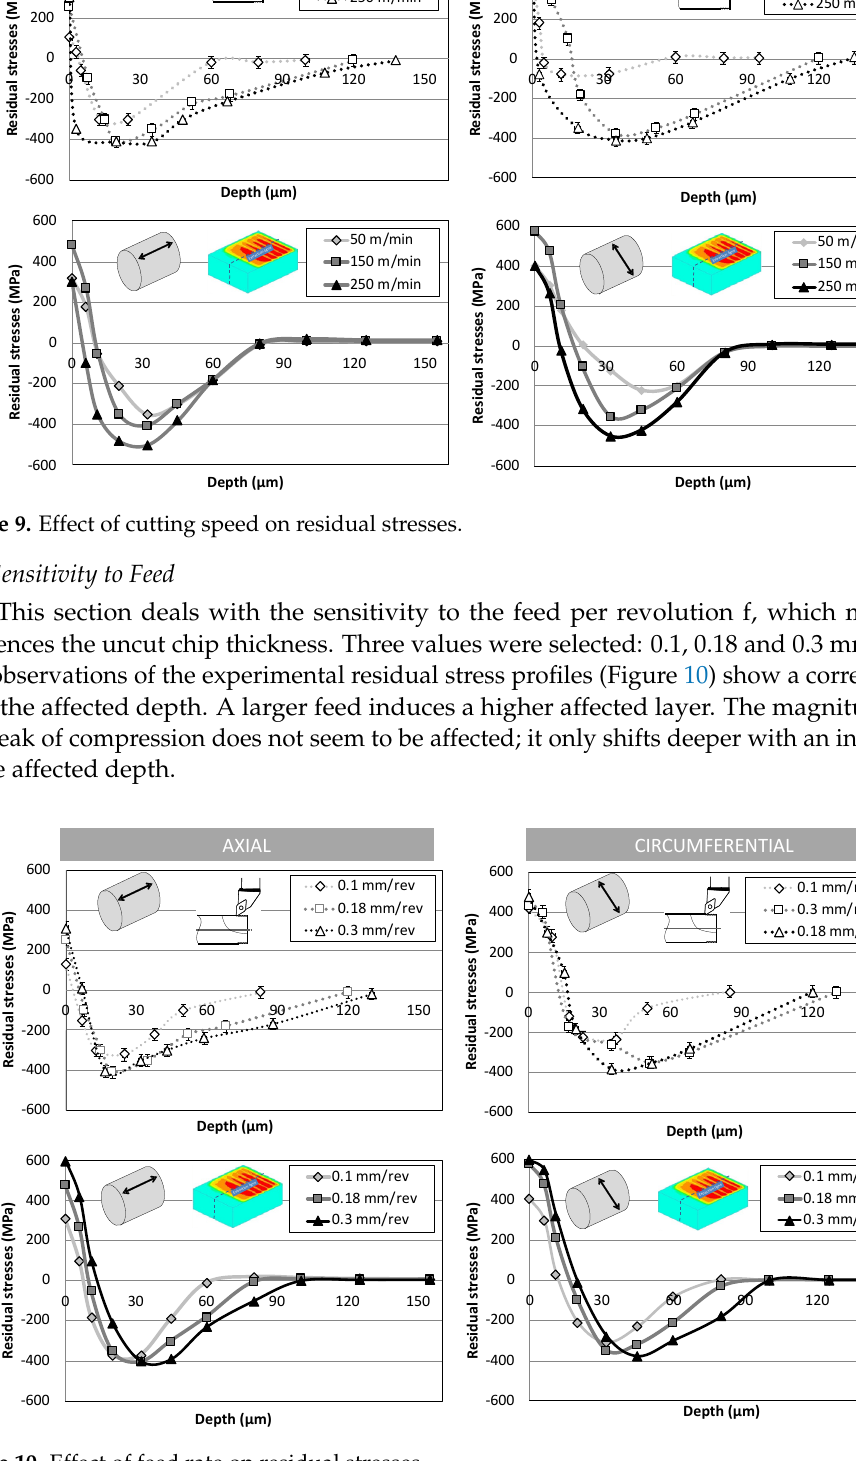
Figure 10. Effect of feed rate on residual stresses.